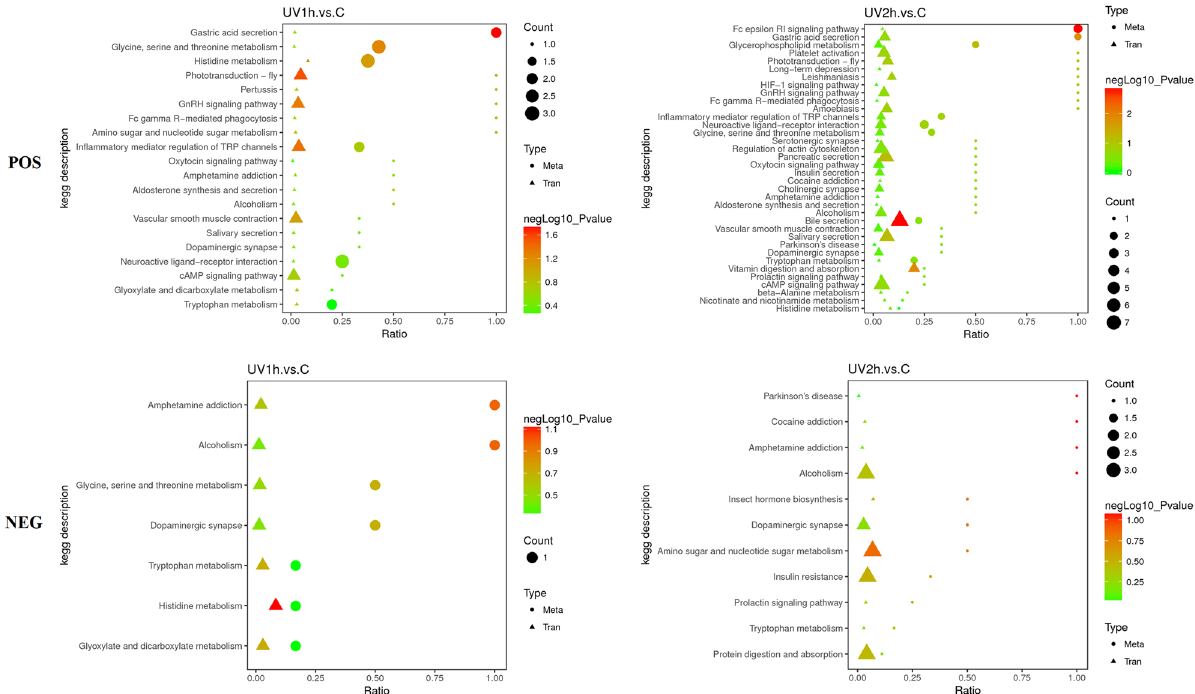
Figure 7. Association analysis of DEG and DEM KEGG pathway. POS positive, NEG negative, Count number of genes or metabolites enriched in the pathway, Type “Tran” indicates transcriptome, while “Meta” means metabolome, DEG differentially expressed gene, DEM differently expressed metabolites, KEGG Kyoto Encyclopedia of Genes and